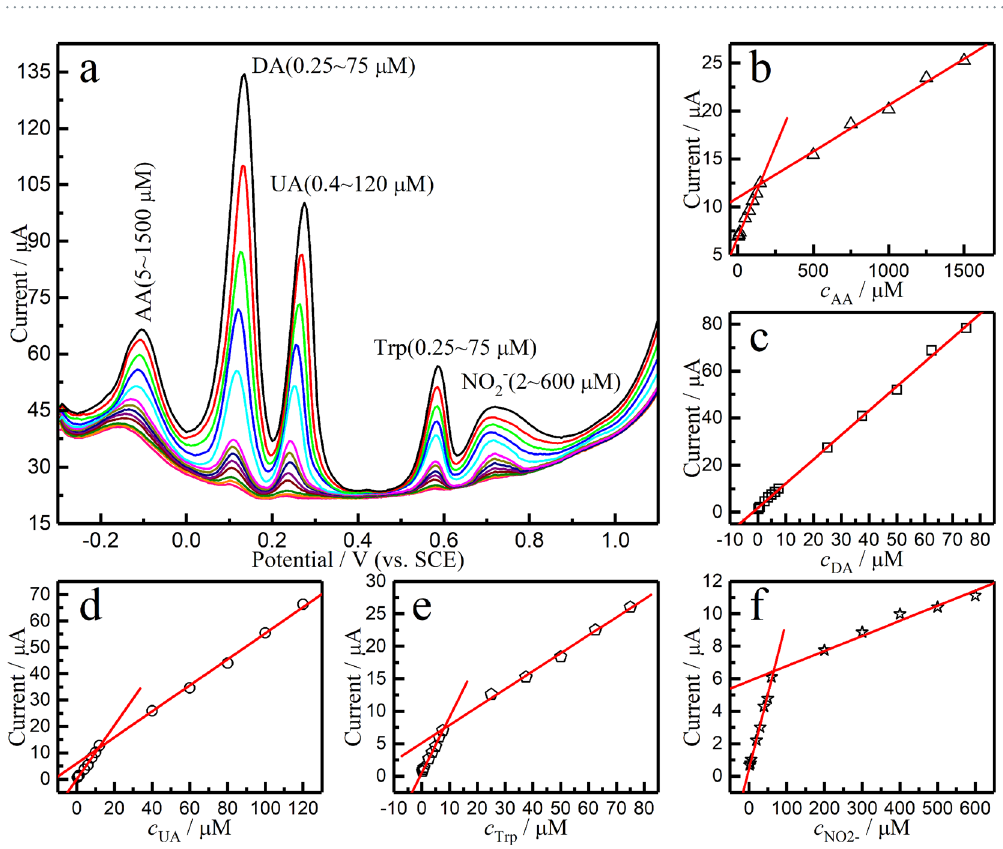
Figure 5. ( a ) DPV curves of graphene/Ta wire electrode in 0.1 M PBS (pH 7.0) with various concentrations of AA, DA, UA, Trp, and − NO . ( b – f ) Plots show peak currents versus the concentrations of AA, DA, UA, Trp, and 2 − NO , 2